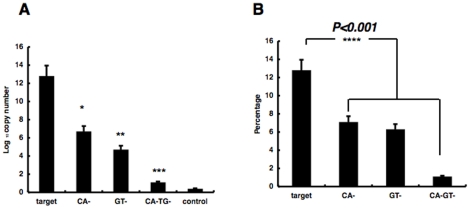
Presence of CA and TG motifs and integration ratio.(A) Number and (B) percentage of PIAP copies from integration into target sequences or sequences lacking 5′-CA-3′ or 5′-GT-3′ dinucleotide motifs (*p<0.001; target vs. CA-; **p<0.001 vs. GT- ; ***p<0.001 vs. CA-GT-; **** p<0.001; target vs. CA-, GT-, CA-GT-). Error bars represent standard deviation (S.E.). The sequences shown display the 6x1y segment of the target DNA. The sequence CA-TG- in Figure 1 indicates an example of CA-TG- sequences.